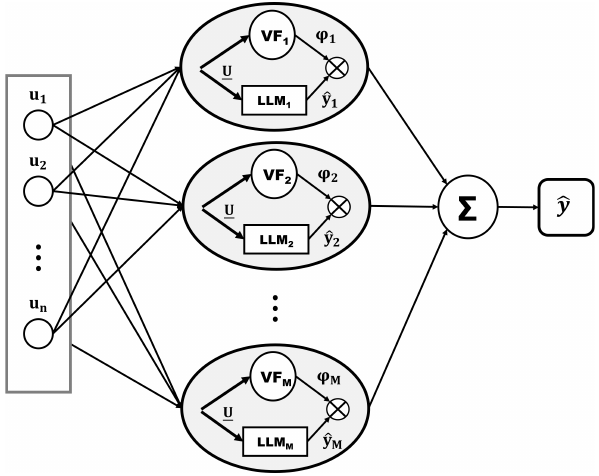
Figure 1. LMN structure with M neurons for n inputs